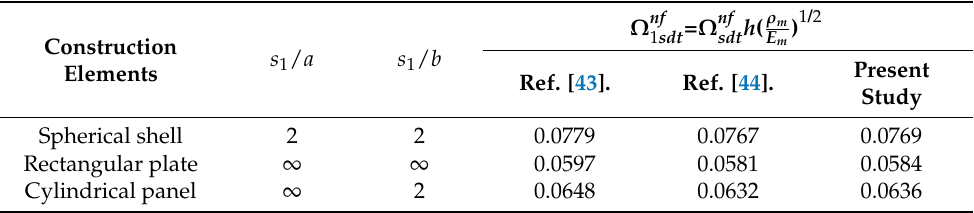
Table 2. Comparison of dimensionless linear frequency parameters of homogeneous isotropic construction elements within SDTs.